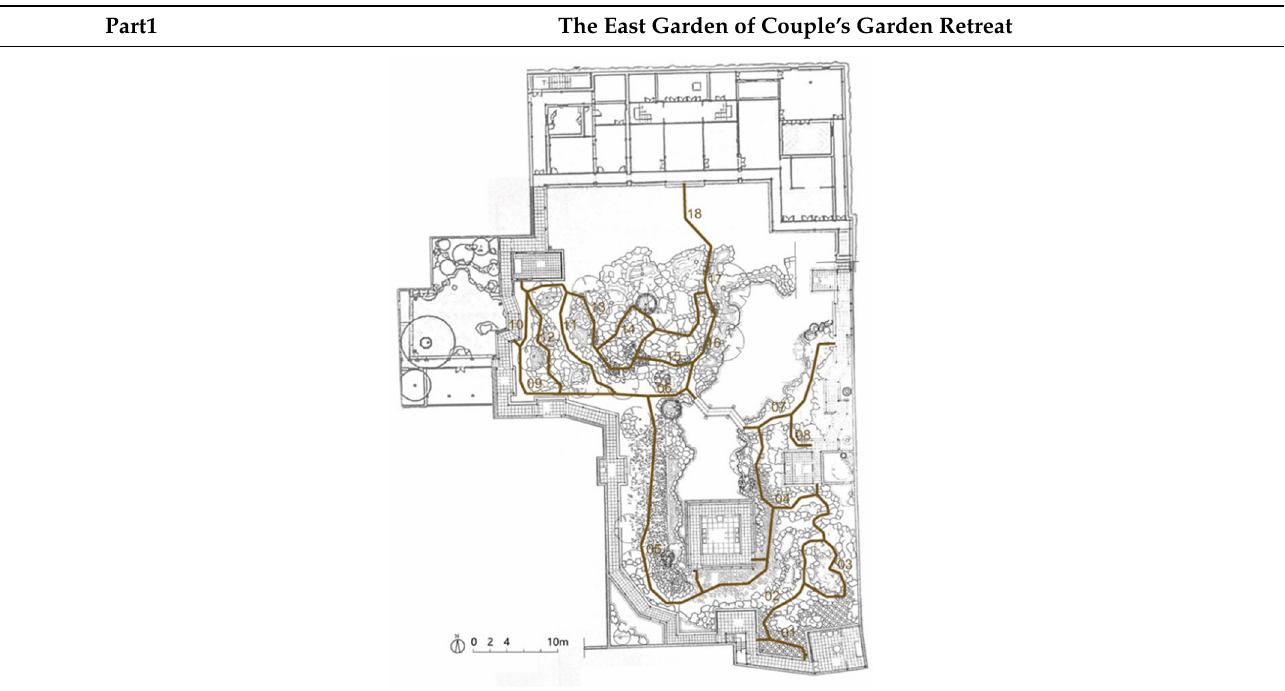
Table A9. Couple’s Garden Retreat, garden path.